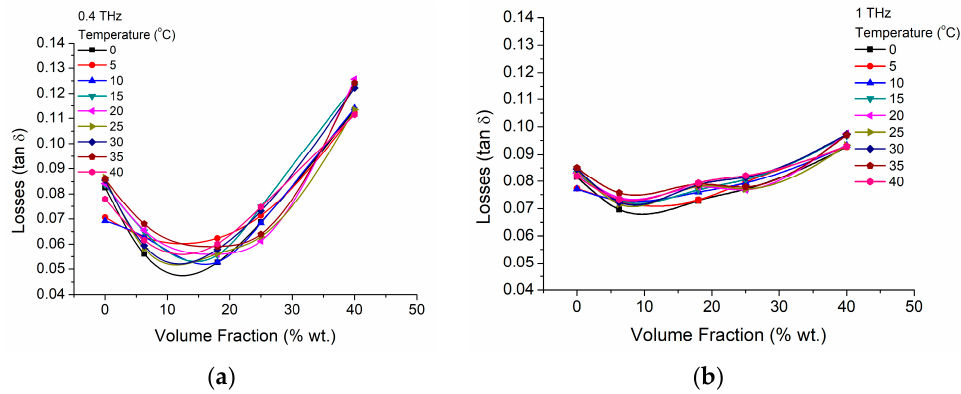
Figure 6. BTO-gelatin losses variation with particle concentration volume fraction variation at ( a ) 400 GHz and ( b ) 1 THz and different temperatures.